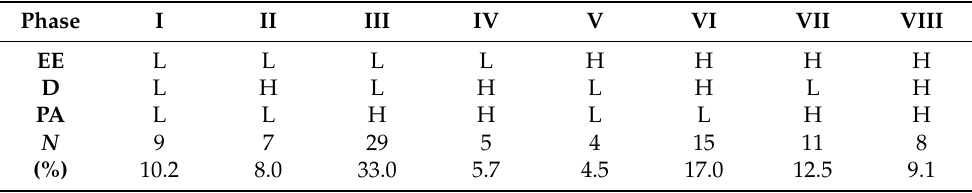
Table 4. Prevalence of burnout by phases according to the Golembiewski model.